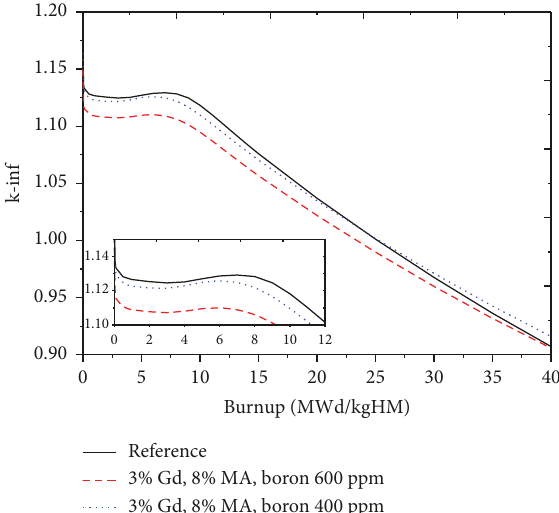
Figure 11: The k-inf versus burnup when loading 8 wt.% of MAs and reducing GD to